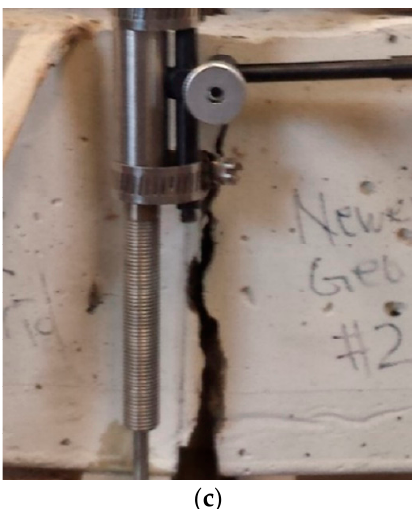
Figure 5. Failure mode of geogrid-reinforced concrete beams: ( a ) crack initiation; ( b ) crack propagation; ( c ) macrocrack with large CMOD.